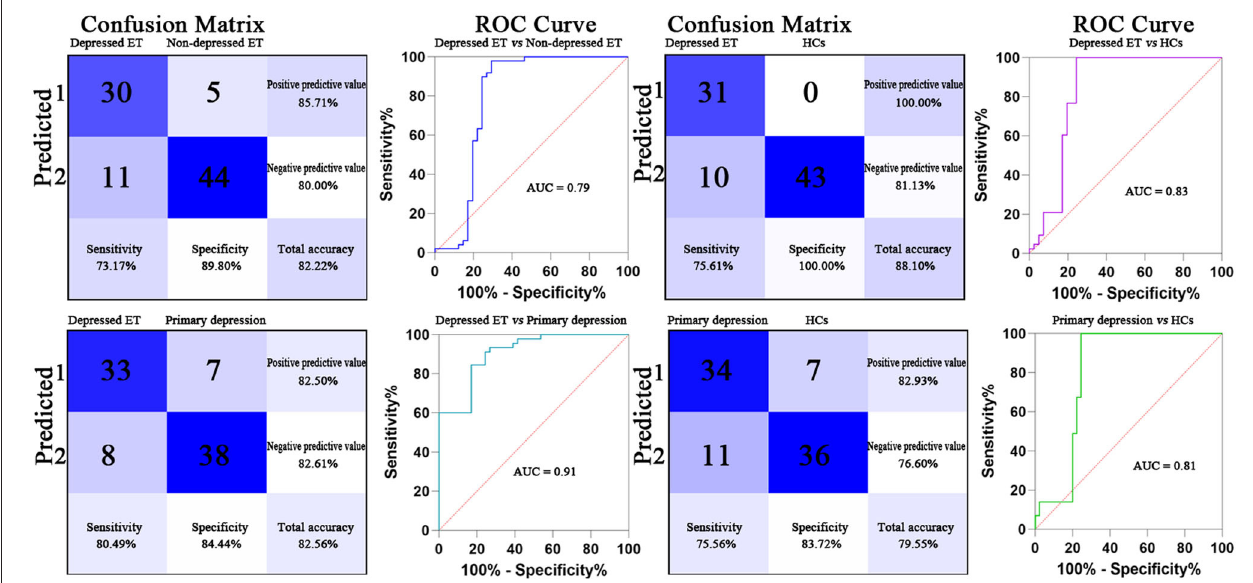
FIGURE 1 | Confusion matrix and ROC curve of the binary SVM algorithm. ET, essential tremor; HCs, healthy controls; ROC, receiver operating characteristic; AUC, area under the curve; SVM, support vector machine.